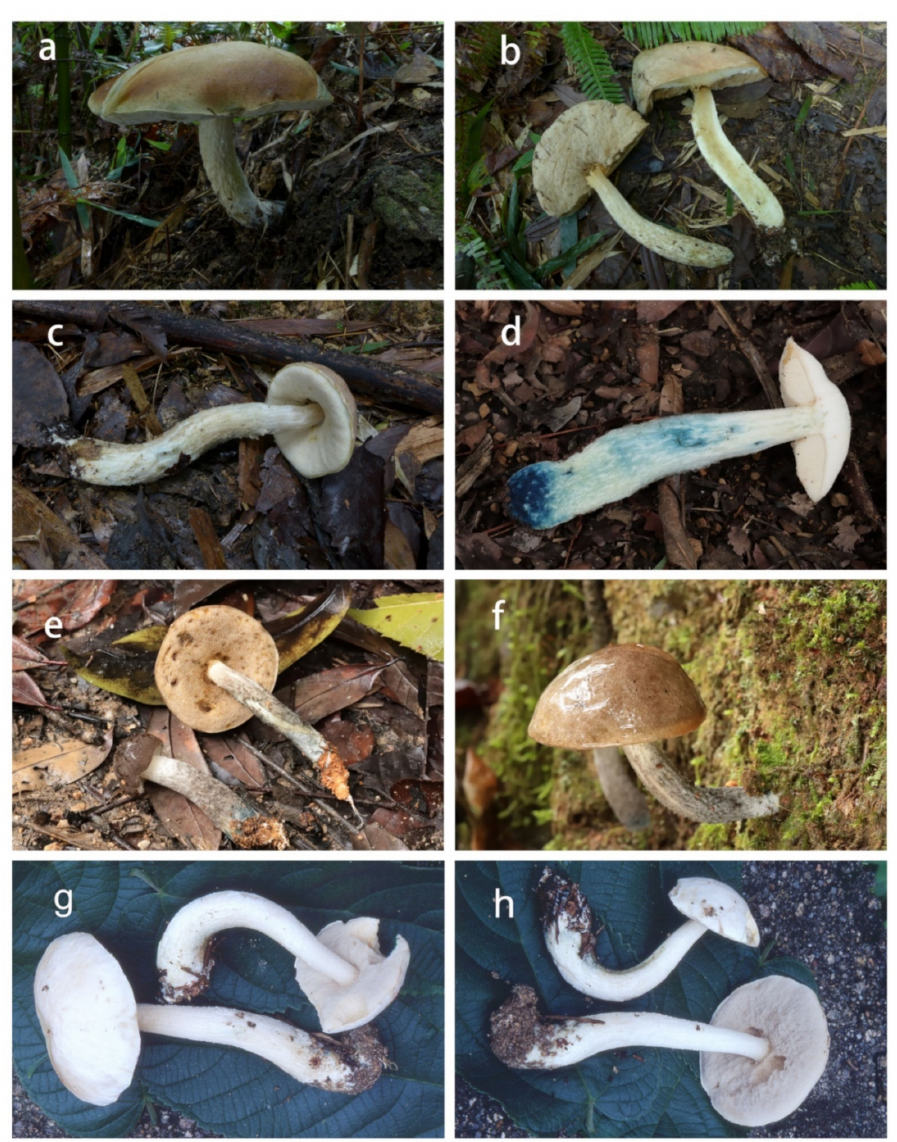
Figure 3. Basidiomata of Leccinum species. ( a – c ) Leccinum parascabrum (KUN-HKAS99903, holotype); ( d – f ) Leccinum pseudoborneense (( d ) from KUN-HKAS110157; ( e , f ) from KUN-HKAS110156, holotype); ( g , h ) Leccinum album (KUN-HKAS53417, holotype). Etymology : Latin “ album ” means white, referring to the color of the